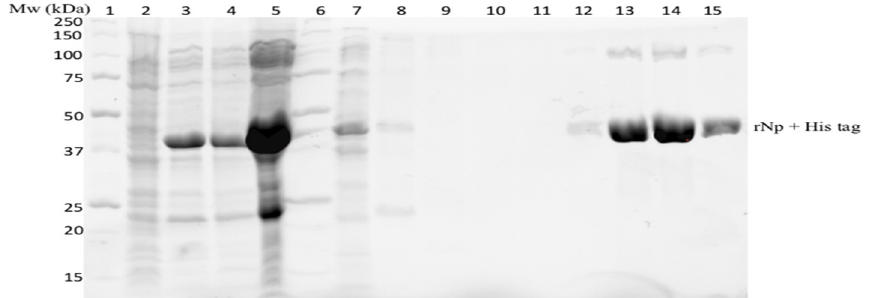
Figure 4. SDS-PAGE of the expressed and purified RVFV rNp. Lanes 1 and 6: Precision Plus Protein Unstained Standard marker, lane 2: uninduced bacterial lysate, lane 3: cell lysate after 4 h induction, lane 4: rNp pellet, lane 5: rNp supernatant, lane 7: flow-through HisTrap HP columns, lanes 8–10: washes and lanes 12–15 eluted rNp protein.